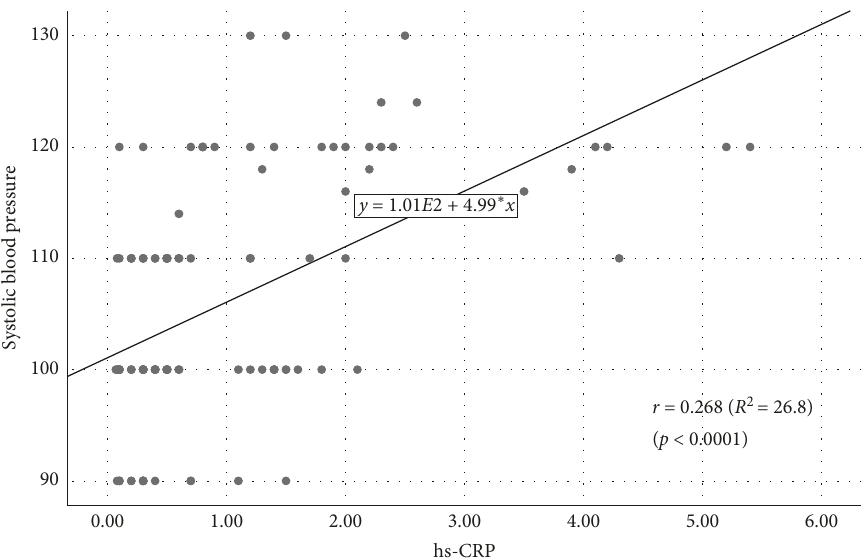
Figure 7: Scatterplot diagram for the association between hs-CRP level and systolic blood